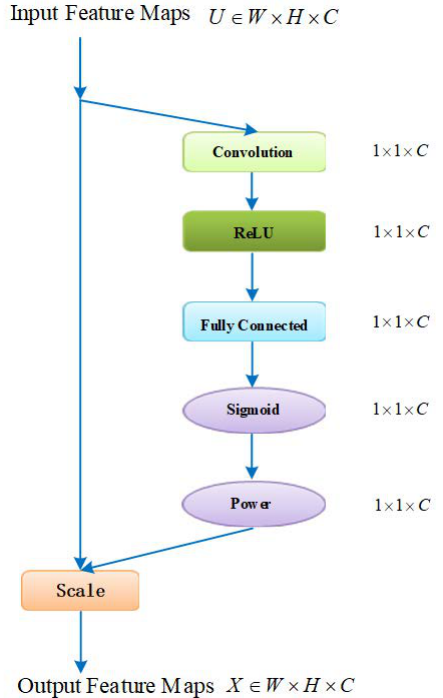
Figure 6. Structure of the enhanced-SE module.